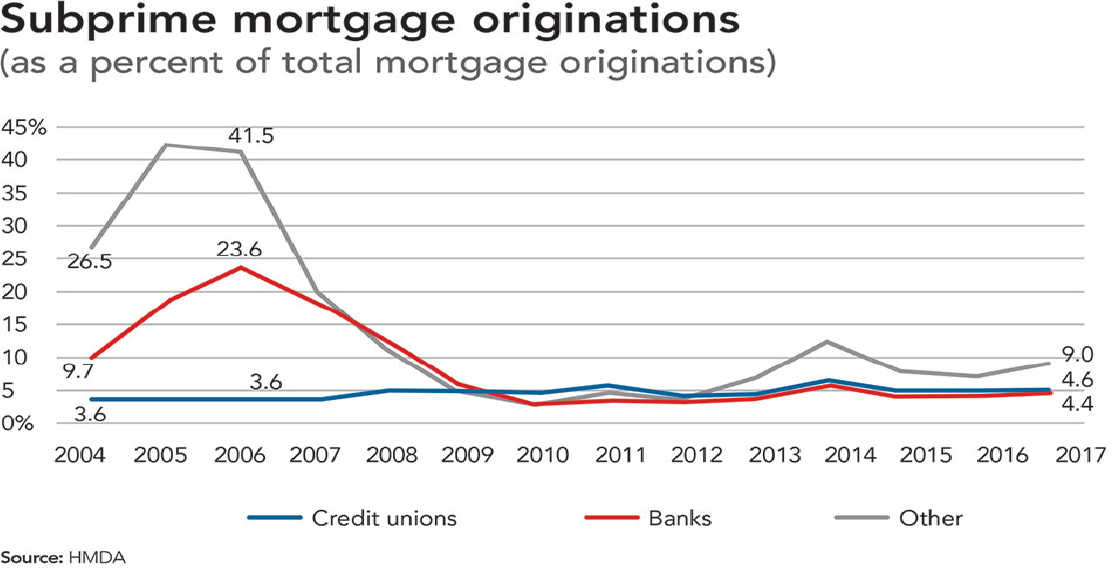
Figure 3. Loss Adjusted Coupon Rate. Source: Davidson Company Inc.